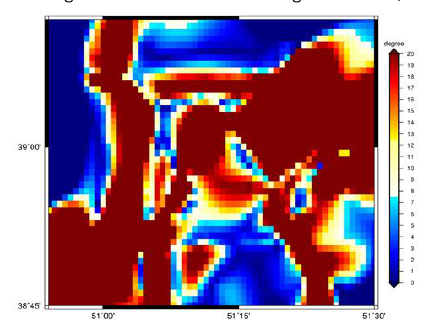
Figure 28. Angular differences between Fig 23 and 24 (in degree)